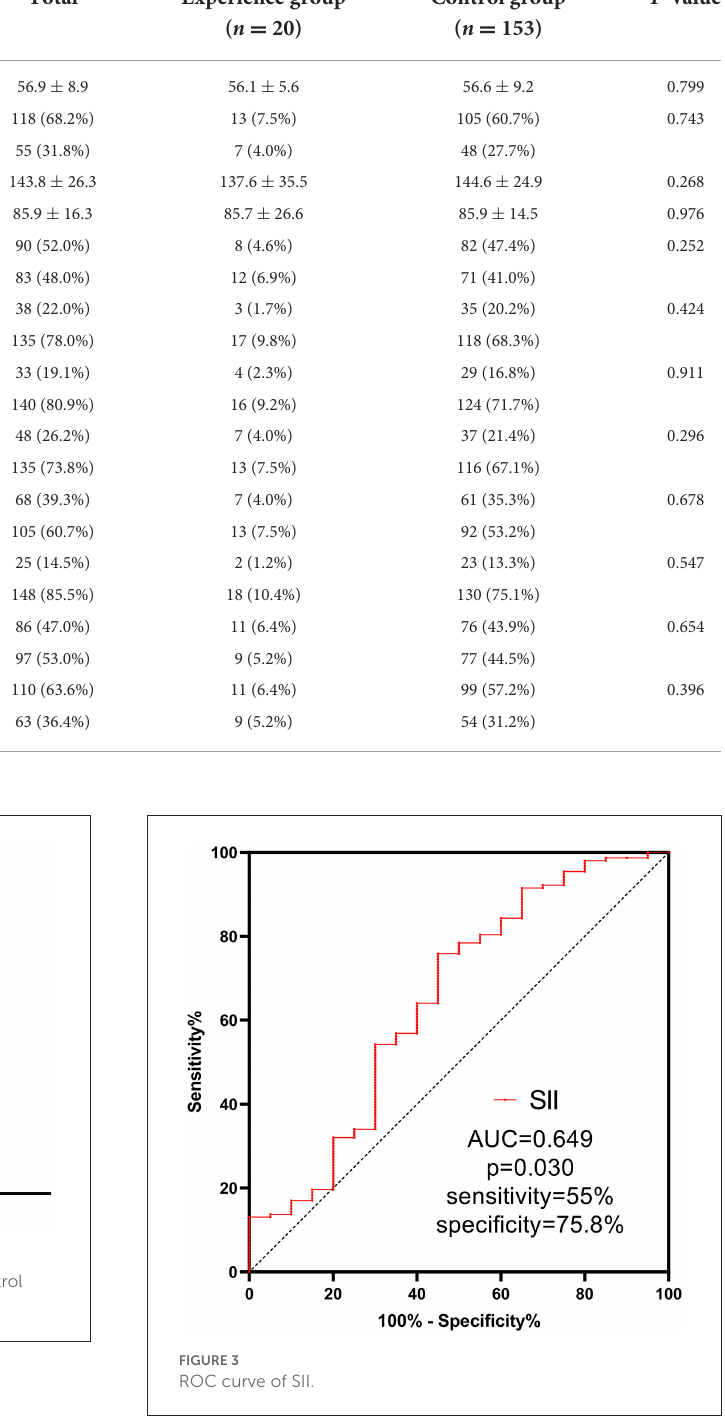
indices, including the SII, serum potassium, responsible artery and PT were binary variables. For SII, 0 represents low SII, and 1 represents high SII. For sex, 0 represents male and